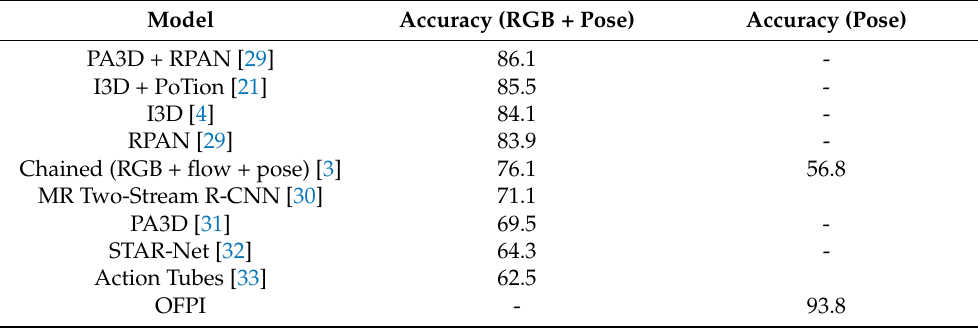
Table 7. Average accuracy per category on the JHMDB dataset compared with state-of-the-art